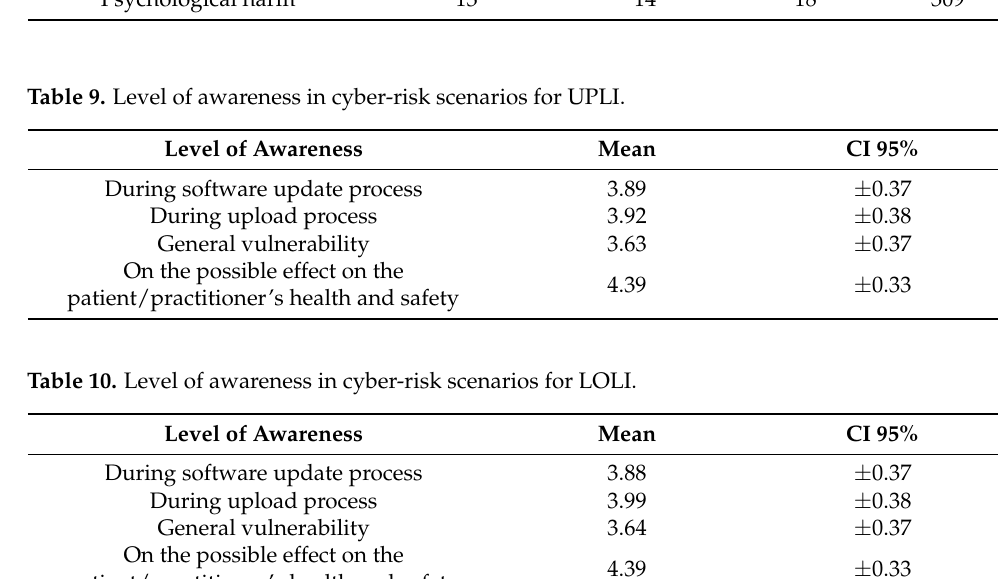
Table 8. Results relating to the graded questions with the details of the assessment. BA LOLI UPLI SR Physical damage 308 309 307 Physical harm 307 Psychological harm